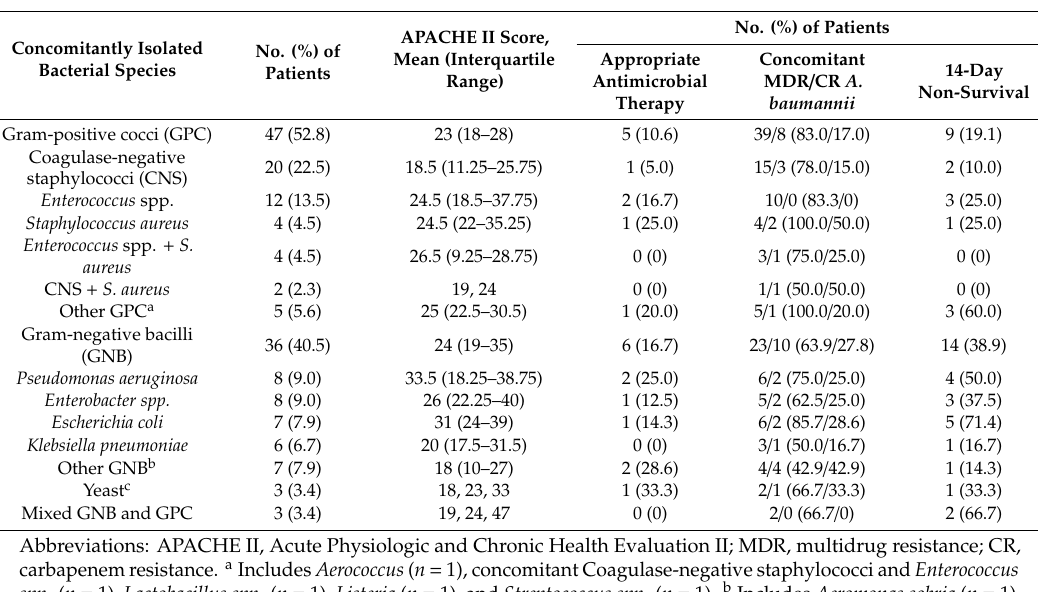
Table 3. Characteristics of patients with polymicrobial Acinetobacter baumannii bacteremia stratified by concomitantly isolated bacterial species.